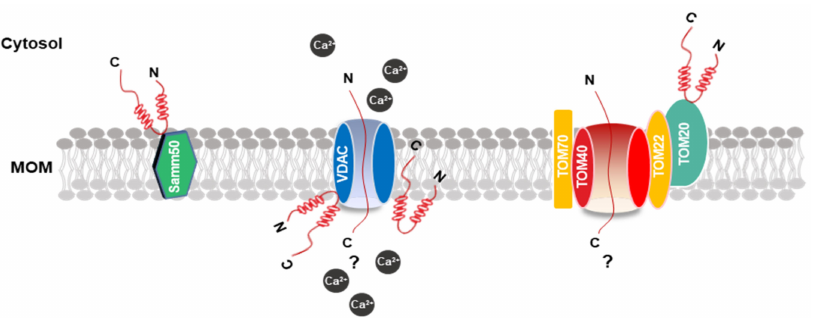
Figure 2. Schematic model of the MOM and α -synuclein association. The picture shows α -synuclein binding patterns at the MOM. Proteins that interact with α -synuclein are highlighted in colors. The possible mechanism of α -synuclein transport into the mitochondria through VDAC and TOM20. α -synuclein is shown in red. MOM, mitochondrial outer membrane; VDAC, voltage-dependent anion